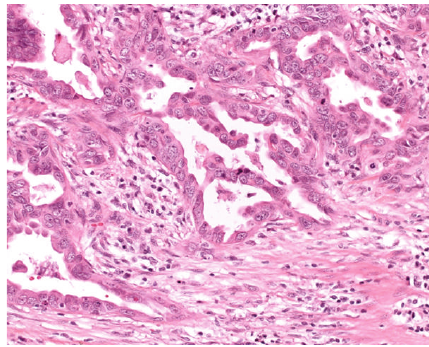
Figure 4: Infiltrating adenocarcinoma G2, H and E,